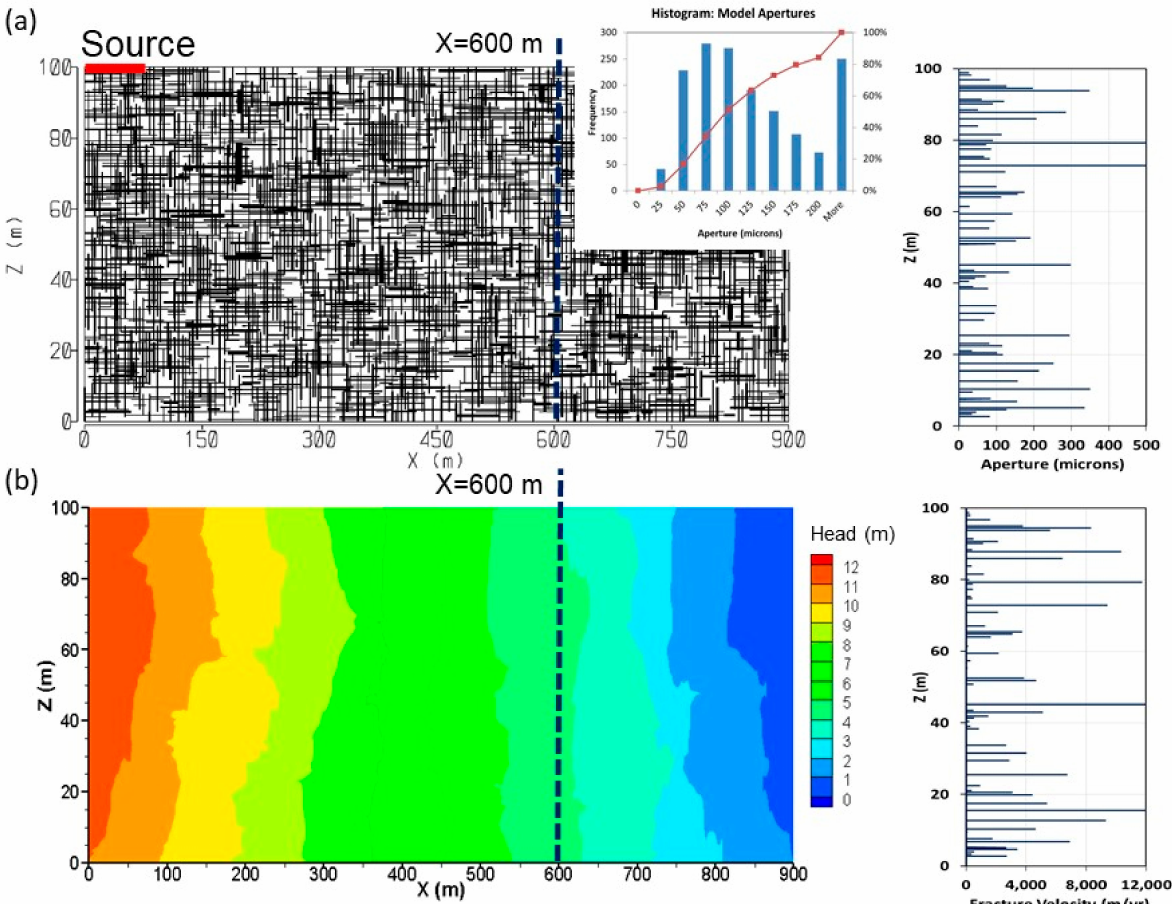
Figure 9. DFM model setup showing ( a ) model domain representing a vertical cross-section along the groundwater flow path and fracture network (inset shows aperture distribution) and example aperture profile at X = 600 m; and ( b ) simulated steady state hydraulic head distribution and example fracture velocity profile at X = 600 m with flow boundary conditions informed by head measurements in conventional and multilevel